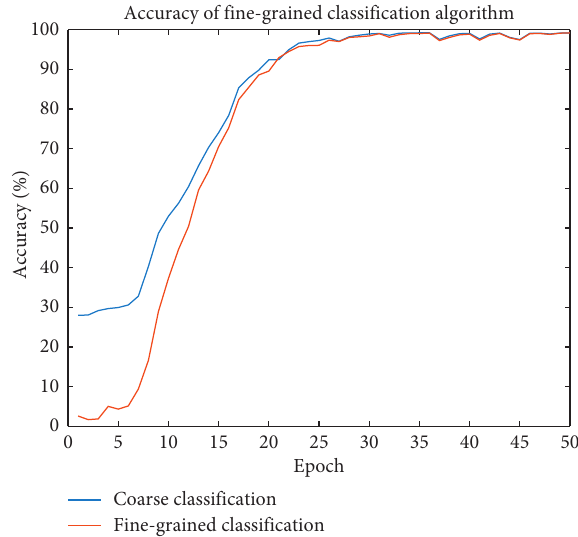
Figure 11: Fine-grained classification (health state) accuracy and coarse classification (working condition) accuracy of CNN-FG.